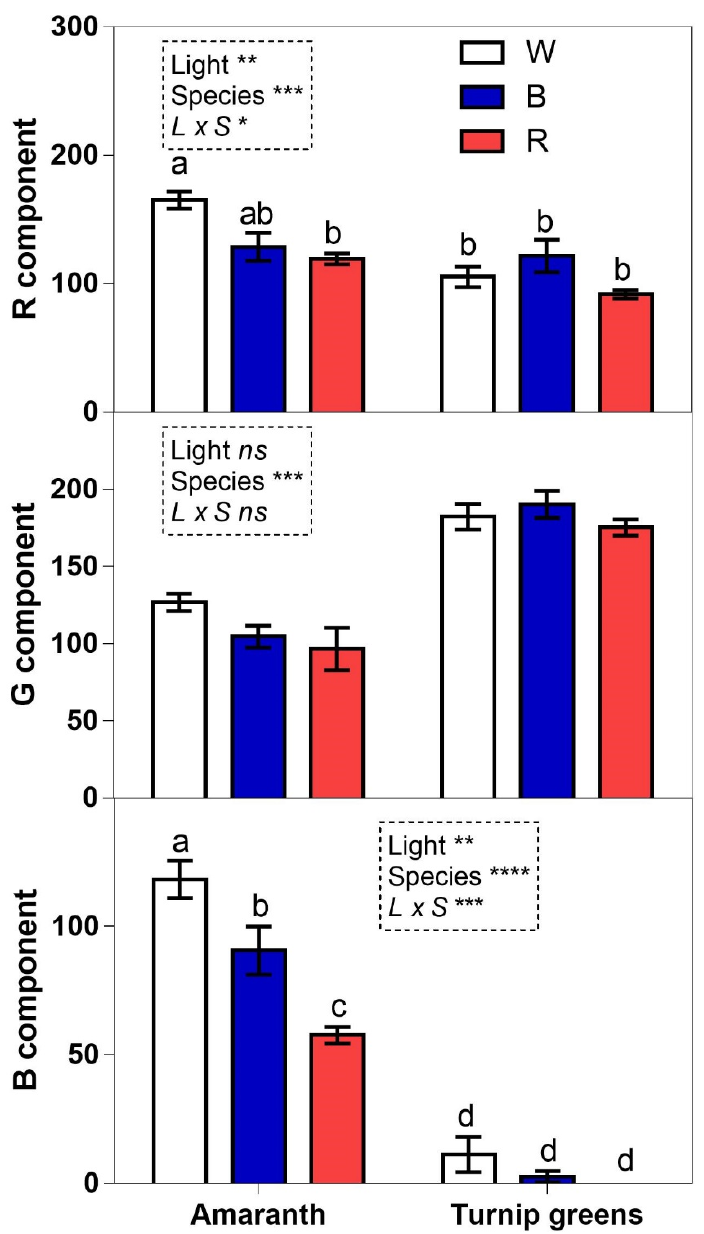
Figure 8. RGB component analysis of microgreen photos grown under different light conditions: white (W), blue (B), and red (R). Values are means with standard errors ( n = 4). Four biological replicates were used for the analysis. Data were subjected to two-way ANOVA. Differences among means were determined using Tukey’s test. Different letters highlight significant differences at p ≤ 0.05; ns not significant, significant at p ≤ 0.05 (*), 0.01 (**), and 0.001 (***).